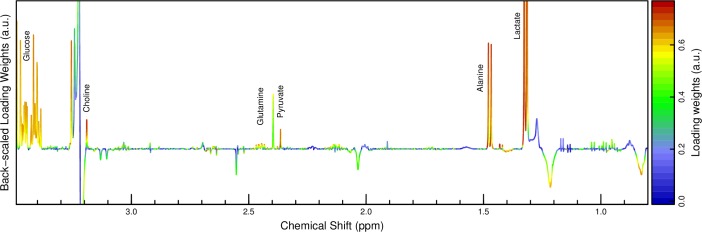
Backscaled PLS-DA loading weights for progression of plasma profiles from time point t1 to t2.First PLS component. The amplitude corresponds to covariance, the color scale to correlation with the group discrimination. The loading weights indicate a consistent increase in among others lactate, alanine and glucose while lipid signals seem to decrease.